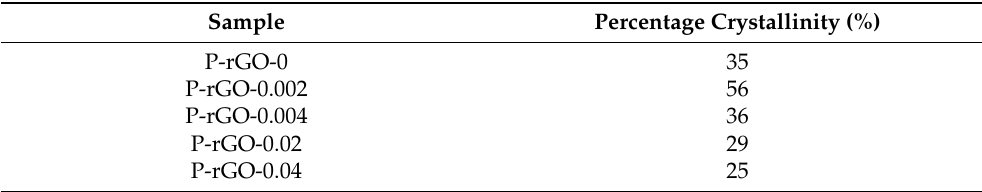
Table 3. Degree of crystallinity (%) calculated from XRD patterns of five thin films.